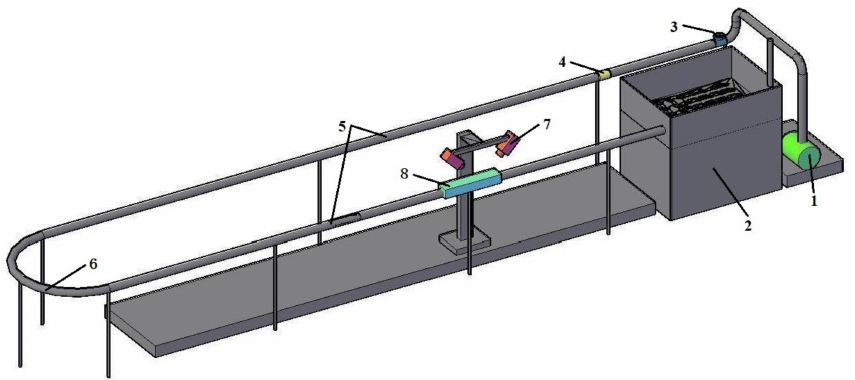
Figure 4. Diagram of experimental platform layout: 1—centrifugal pump; 2—tank; 3—regulator valve; 4—electromagnetic flow meter; 5—flat, straight pipe; 6—flat, curved pipe; 7—particle image velocimeter; 8—test section.